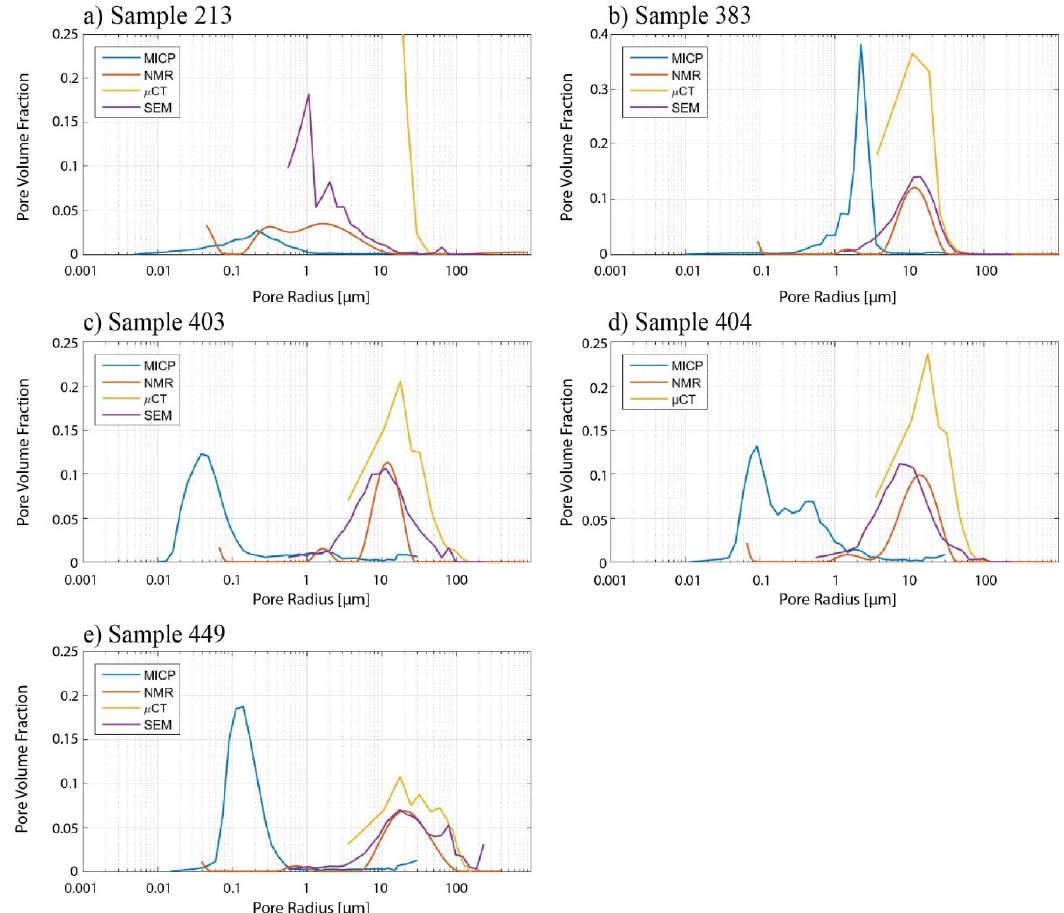
Figure 15. Surface relaxivity determination of samples 213 ( a ), 383 ( b ), 403 ( c ), 404 ( d ) and 449 ( e ) based on T 1 relaxation times. The surface relaxivity was determined through shifting the NMR curve on top of the SEM and the CT.